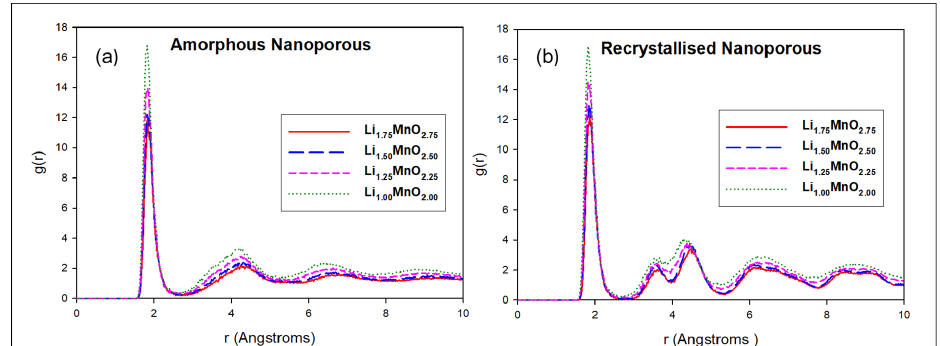
Figure 2. Mn–O pair distribution for the nanoporous 75 Å, before ( a ) and after ( b ) recrystallisation, where Li 1.75 MnO 2.75 , Li 1.50 MnO 2.50 , Li 1.25 MnO 2.25 , and Li 1.00 MnO 2.00 concentrations are illustrated by red, blue, pink, and green, respectively.